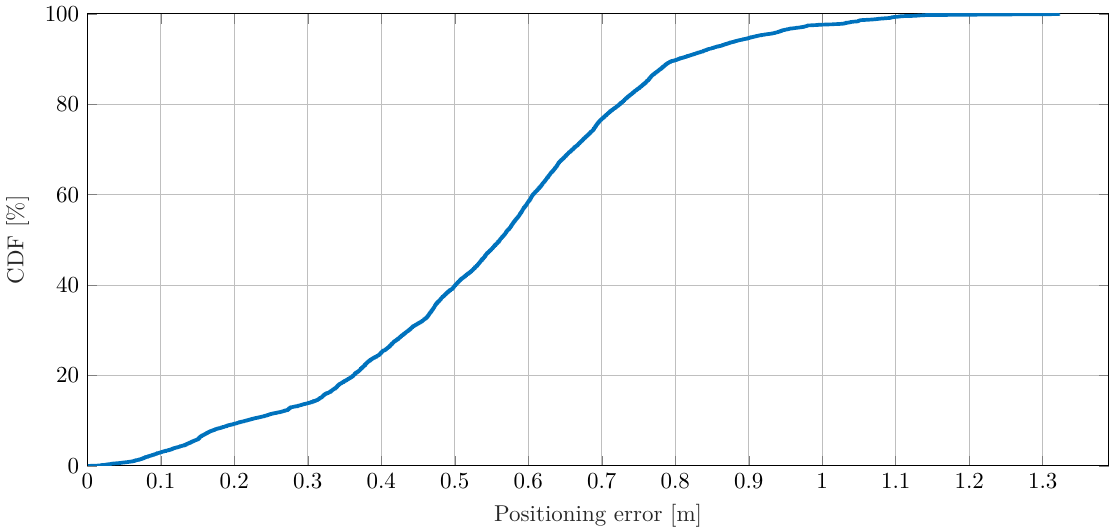
Figure 5. Positioning results of localization approach based on channel measurements—absolute positioning error of moving pedestrian over time.